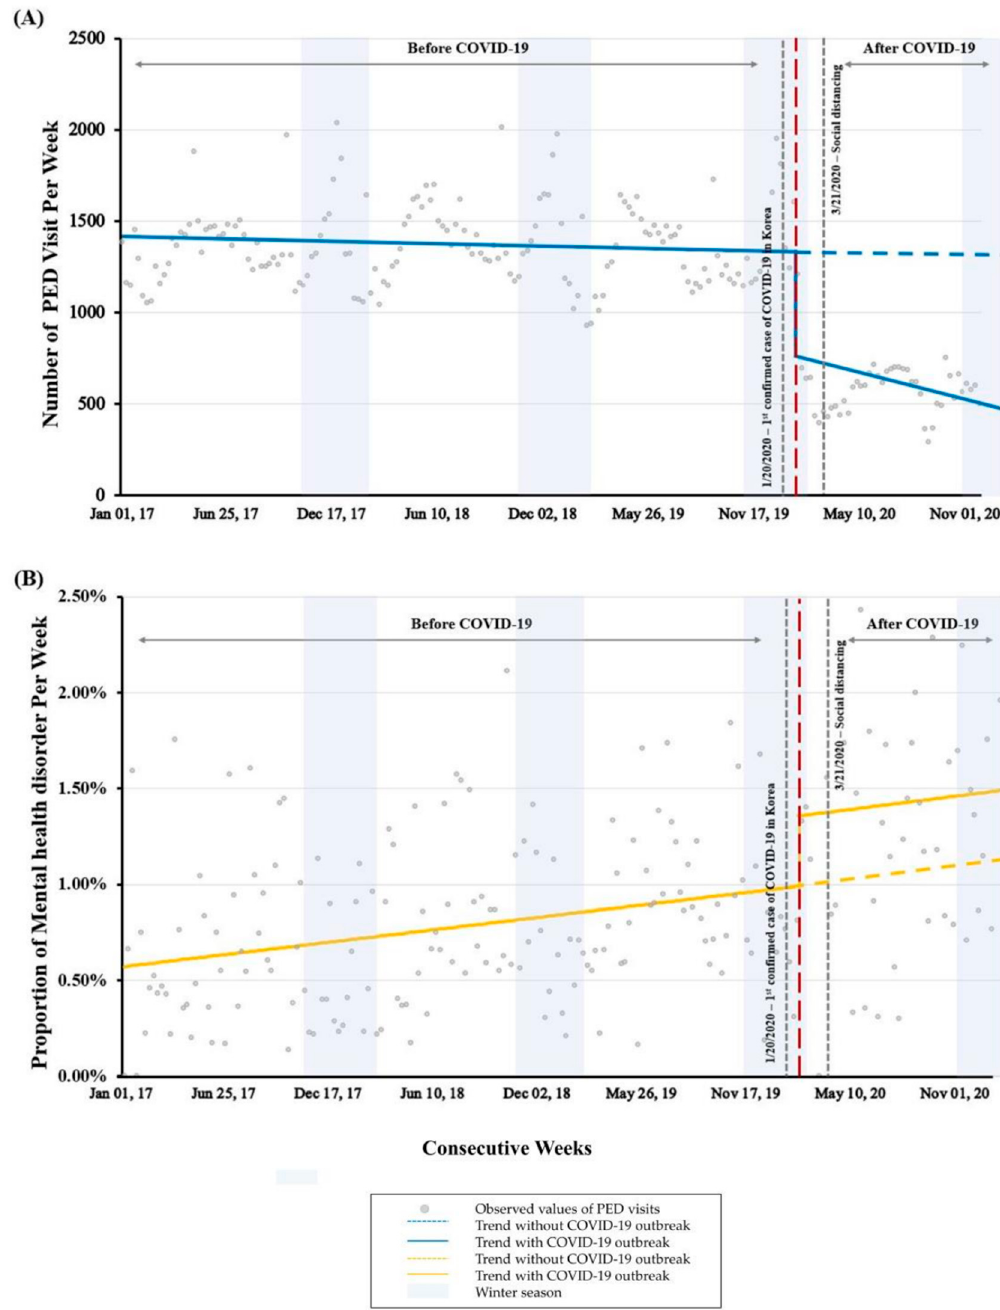
Figure 2. Segmented regression analysis of patients visiting the PED. Compared to before the COVID-19 pandemic, the weekly number of PED visits ( A ) have decreased significantly ( p < 0.001) and the proportion of patients with mental illness ( B ) have increased significantly ( p = 0.03). PED, pediatric emergency department. COVID-19, coronavirus disease 2019.